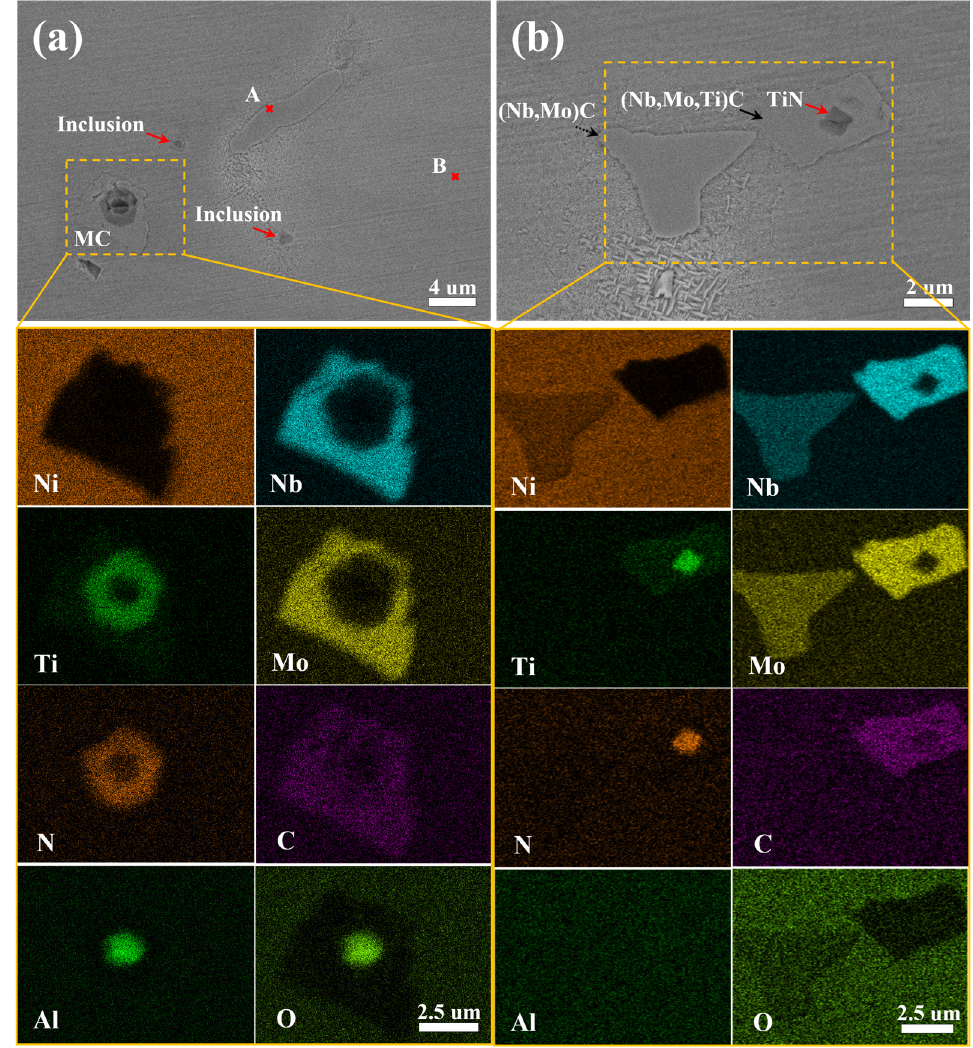
Figure 4. SEM-mapping micrographs and EDS-point analysis results of as-cast GH4169 with etchant 1. ( a ) Distribution of segregation structure. ( b ) Typical composite structures of inclusions and MC. Table 3. Composition analysis and phase identification in Figure 4a measured by EDS point